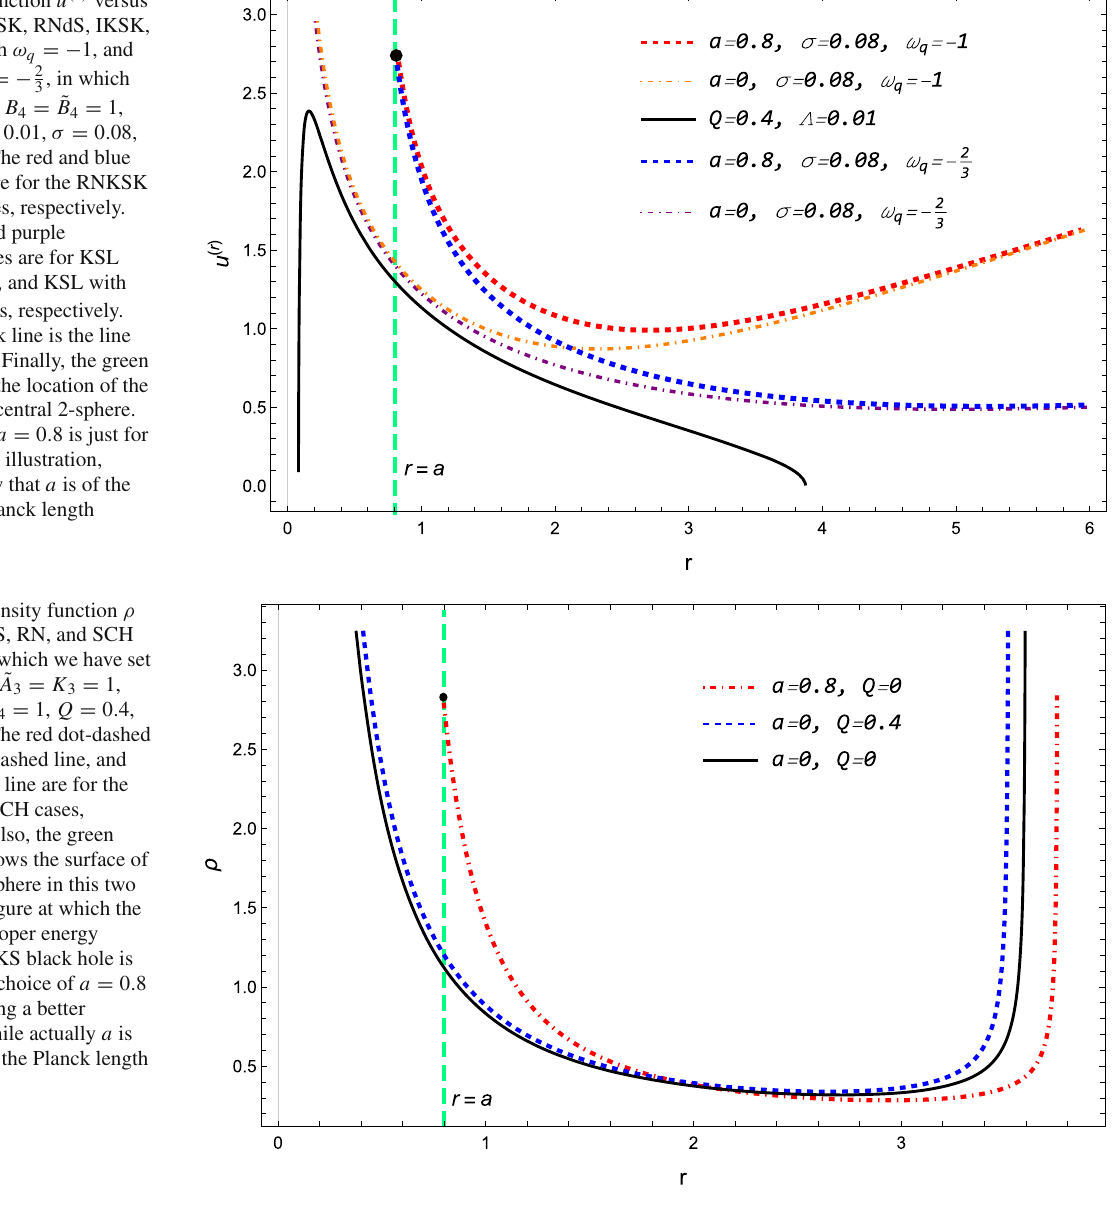
Fig. 2 The function u ( r ) versus r for the RNKSK, RNdS, IKSK, KSL cases with ω q = − 1, and , in which KSL with ω q = − 2 3 we set M = 1, B 4 = ˜ B 4 = 1, Q = 0 . 4, (cid:12) = 0 . 01, σ = 0 . 08, and a = 0 . 8. The red and blue dashed lines are for the RNKSK and IKSK cases, respectively. The orange and purple dot-dashed lines are for KSL with ω q = − 1, and KSL with ω = − 2 cases, respectively. q 3 The thick black line is the line of RNdS case. Finally, the green dashed line is the location of the surface of the central 2-sphere. The choice of a = 0 . 8 is just for